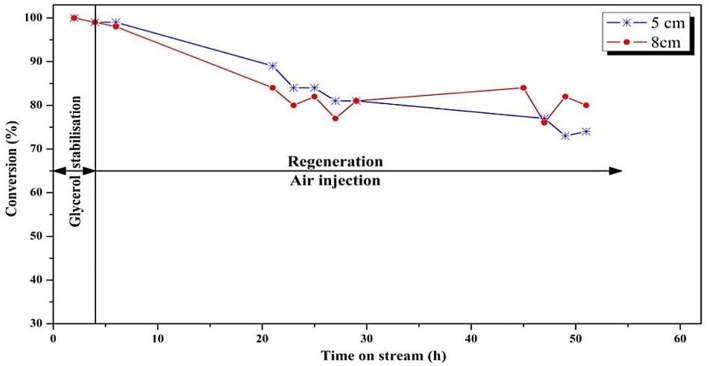
Influence of position of the feed injection in the fluidized-bed on the conversion of glycerol (T = 275°C, O2/Gly = 0.4, gas velocity = 1.86.10−2 m/s). Five centimeters correspond to Vreaction/Vregeneration = 2 whereas 8 cm correspond to Vreaction/Vregeneration = 1.